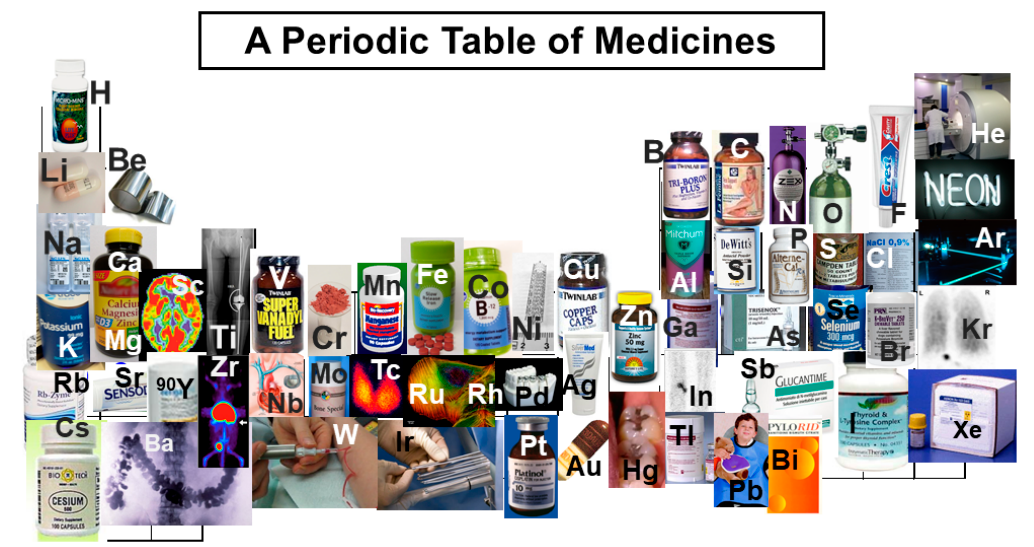
Figure 1. The periodic table with known medicinal uses of each main group or transition metal element when available. In the following, we list the use of each element. Hydrogen (H), boron (B), carbon (C), calcium (Ca), phosphorous (P), potassium (K), magnesium (Mg), vanadium (V), manganese (Mn), iron (Fe), cobalt (Co), copper (Cu), zinc (Zn), selenium (Se), rubidium (Ru), molybdenum (Mo), and cesium (Cs) are commonly found in supplements readily available to the public and are illustrated as such. Helium (He) is crucial in the operation of MRI machines. Lithium (Li) as lithium carbonate is the most common treatment of bipolar disorder. Beryllium (Be) foil is used as shielding in radiographic instruments. Nitrogen (N), as nitrous oxide, is a common anesthetic. Oxygen (O) has many medical uses, including anesthetics and resuscitation, and is illustrated here for use in ventilation. Fluorine (F) and tin (Sn) as stannous fluoride are a common ingredient in toothpaste. Sodium (Na) and chlorine (Cl) are used as NaCl in saline solutions. Aluminum (Al) compounds are a common active ingredient in antiperspirant deodorants. Silicon (Si) is used in antacid products. Sulfur (S) is illustrated as campden tablets, which are used for sterilization in beer fermentation. Argon (Ar) lasers are used in eye surgery. Zirconium (Zr) is used in immuno-positron emission tomography (PET) imaging while scandium (Sc) is a candidate for the same technique. Titanium (Ti), palladium (Pd), niobium (Nb), nickel (Ni), and tantalum (Ta) are used in medical implants. Chromium (Cr) is shown as Cr(III) picolinate, which is a controversial supplement used in lowering insulin resistance. Gallium (Ga), yttrium (Y), technetium (Tc), lanthanum (La), astatine (At), and actinium (Ac) are all used in nuclear medicine. Arsenic (As), as As(III) trioxide, is used to treat certain forms of leukemia. Bromine (Br) as KBr is an active ingredient in canine seizure medication. Krypton (Kr) was used in lung ventilation studies but has since been phased out. Strontium (Sr) is used in Sensodyne ® toothpaste. Rhodium (Rh), ruthenium (Ru), and rhenium (Re) complexes are used as anticancer agents. Silver (Ag) is used in antibacterial ointments. Indium (In) is used in white blood cell scans. Antimony (Sb) is used in leishmania medicine. Barium (Ba) is used in X-ray imaging of the gastrointestinal tract. Tungsten (W) is used in shielded syringes. Iridium (Ir) is used in brachytherapy. Gold (Au) was used as a treatment for rheumatoid arthritis but has been phased out. Mercury (Hg) is used in dental amalgams. Lead (Pb) is used in X-ray aprons. Bismuth (Bi) is used in stomach ulcer medicine. Neon (Ne), germanium (Ge) cadmium (Cd), tellurium (Tl), hafnium (Hf), osmium (Os), polonium (Po), francium (Fr), radon (Rn), and radium (Ra) although most of these are toxic elements for human life, some of these elements are under development as potential agents for disease treatment but to our knowledge they are not currently used for benefical applications in medicine. References to most of these facts are dispersed throughout the